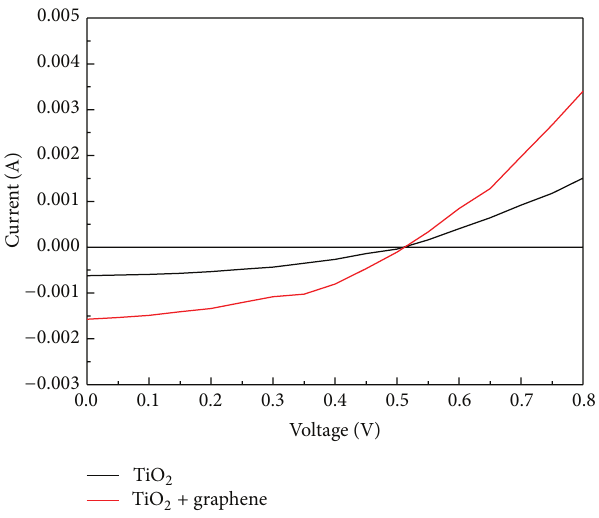
Figure 3: 𝐽 - 𝑉 curves of the DSSCs with and without the graphene electron transfer layer under